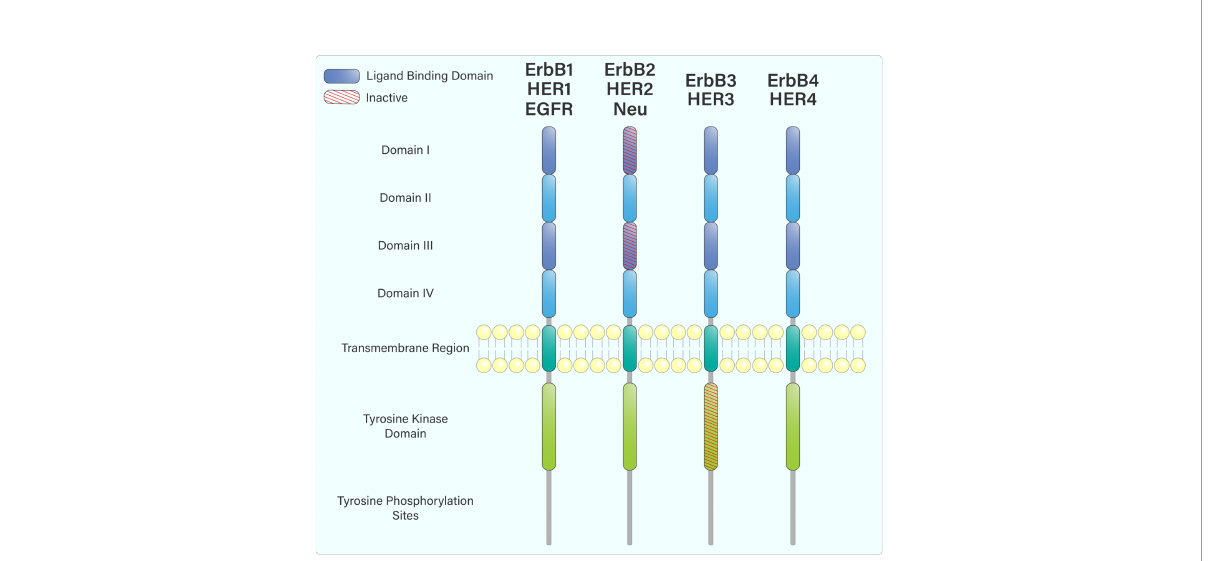
FIGURE 1 The domain arrangement of the ErbB receptor family. The extracellular region is composed of 4 domains: I, II, III & IV. Domains I and III (purple) form an extracellular ligand-binding domain that facilitates ligand attachment at the cell surface. ErbB2, while containing a ligand-binding domain, does not bind any ligands. Upon ligand engagement, the ErbB family members hetero- or homodimerize with each other, leading to trans-autophosphorylation of tyrosine residues within their cytoplasmic tails through their intracellular tyrosine kinase domain. ErbB3 does not have an active tyrosine kinase domain and must heterodimerize with another ErbB receptor to be